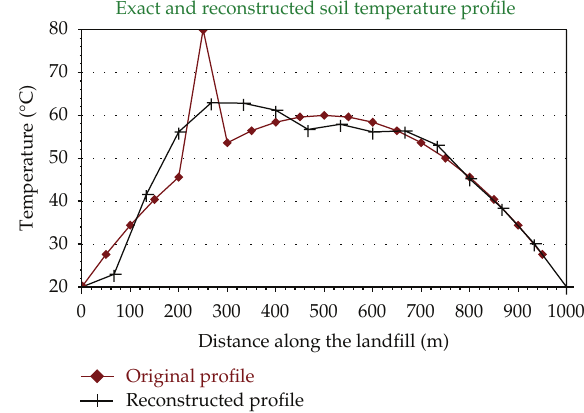
Figure 7: Fifteen intervals—double Tikhonov’s regularisation